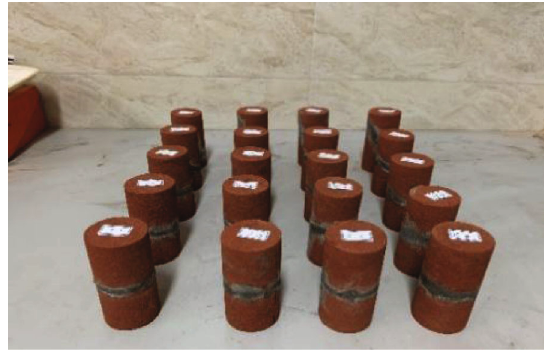
Figure 4: Red sandstone crack grouted body